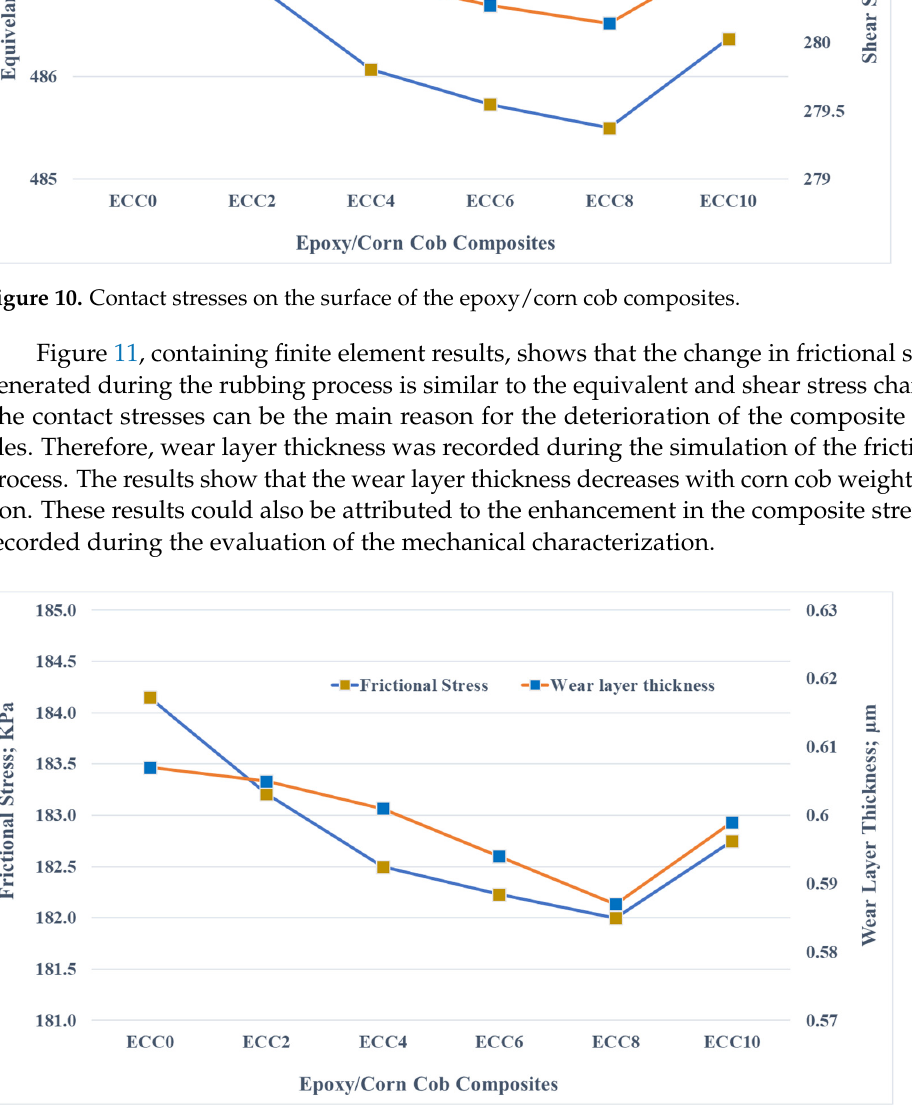
Figure 11. Frictional stress and wear layer thickness on the surface of the epoxy/corn cob composites. To validate the finite element results and evaluate the influence of different corn cob weight fractions on the tribological performance of epoxy composites, the specific wear rate of the epoxy composites under different normal loads was calculated. Figure 12 shows that incorporating corn cob particles in the epoxy resin decreased the specific wear rate. According to the results, 8 wt% corn cob recorded the minimum specific wear rate. Nevertheless, the extra addition of corn cob to reach 10 wt% increased the specific wear rate. The increase in wear rate to more than 8 wt% corn cob could be attributed to the agglomeration of corn cob particles due to high weight percent [25]. Furthermore, the high